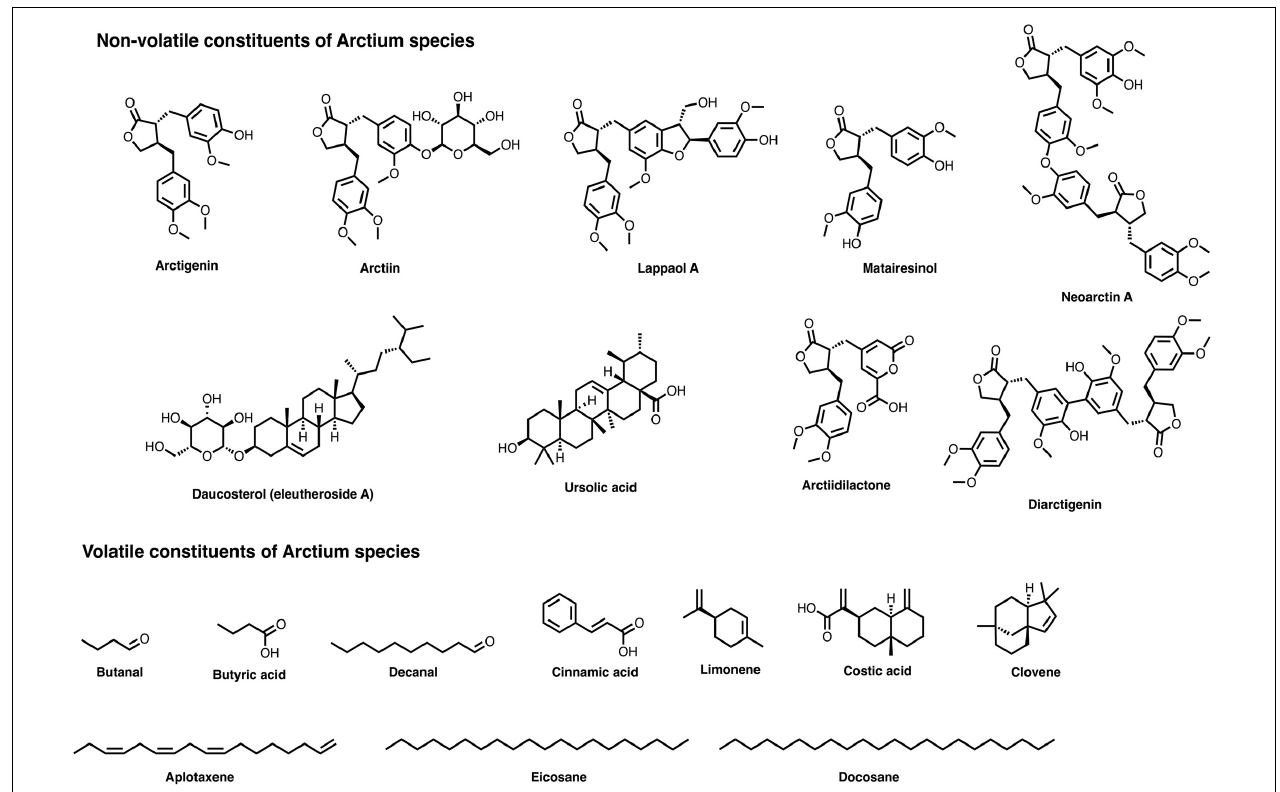
FIGURE 2 | Chemical structures of several relevant components present in Arctium